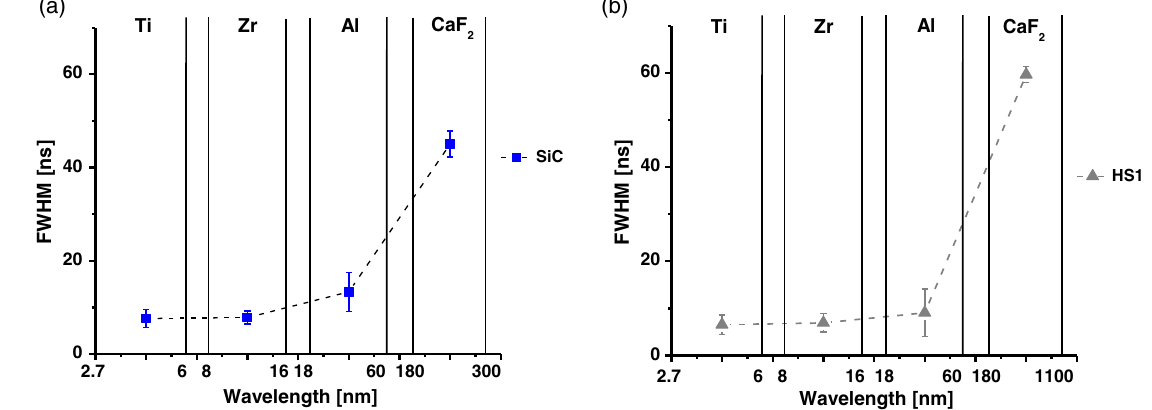
FIG. 4. Xe plasma emission evolution, for a gas-puff pressure constant, of 10 bar. Comparison of (a) SiC and (b) HS1 signals (in terms of FWHM) in different wavelength ranges limited by various filters. The CaF 2 range spans a wavelength range of 180 nm to 10 μ m, but the spectral sensitivity of HS1-Si and SiC detector with such a filter is from 180 to 300 nm (a) and from 180 to 1100 nm (b) wavelength, respectively. The statistical vertical error bar, over ten measurements, is reported as 20 σ for Ti, Zr, and Al filters and as 1 σ for the CaF 2 filter, where σ is the standard